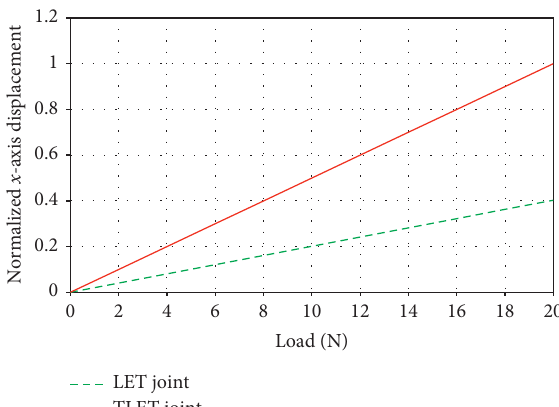
Figure 9: Comparison of the displacement between the LET joint and the TLET joint.